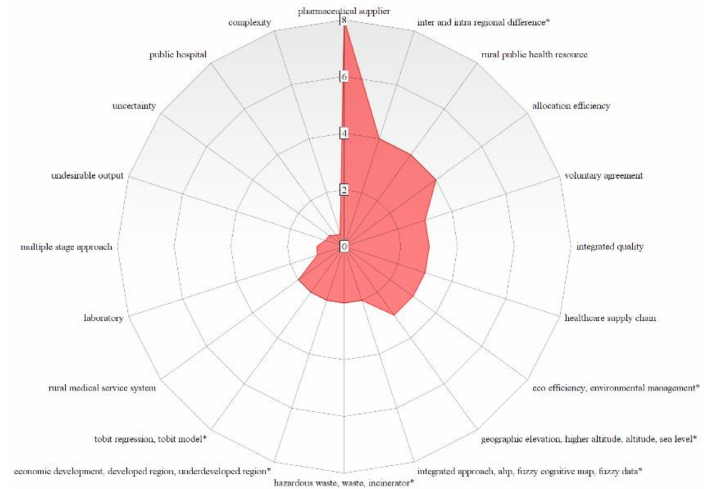
Figure 9. Hot Topics for a Research Agenda in the Red Cluster.